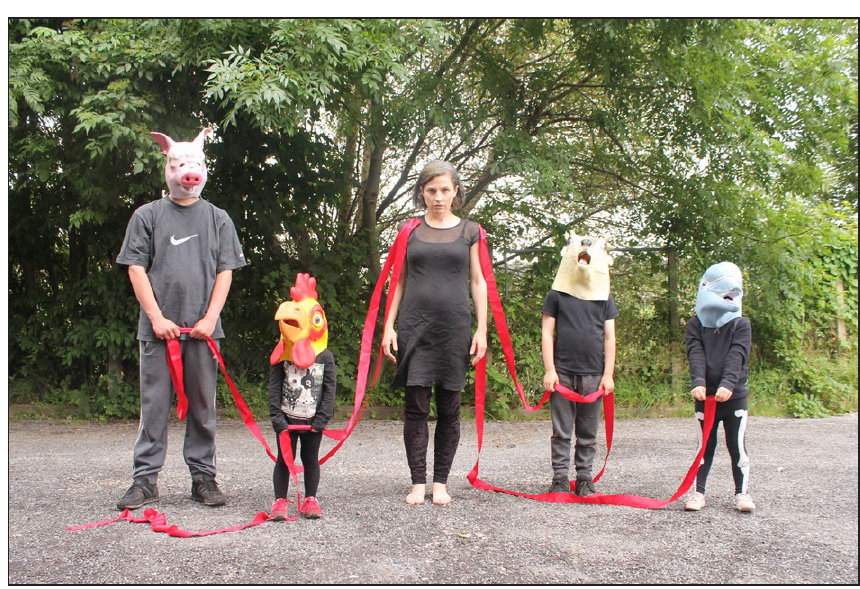
Figure 30: Paula McCloskey, Becoming-Animal , digital photograph,